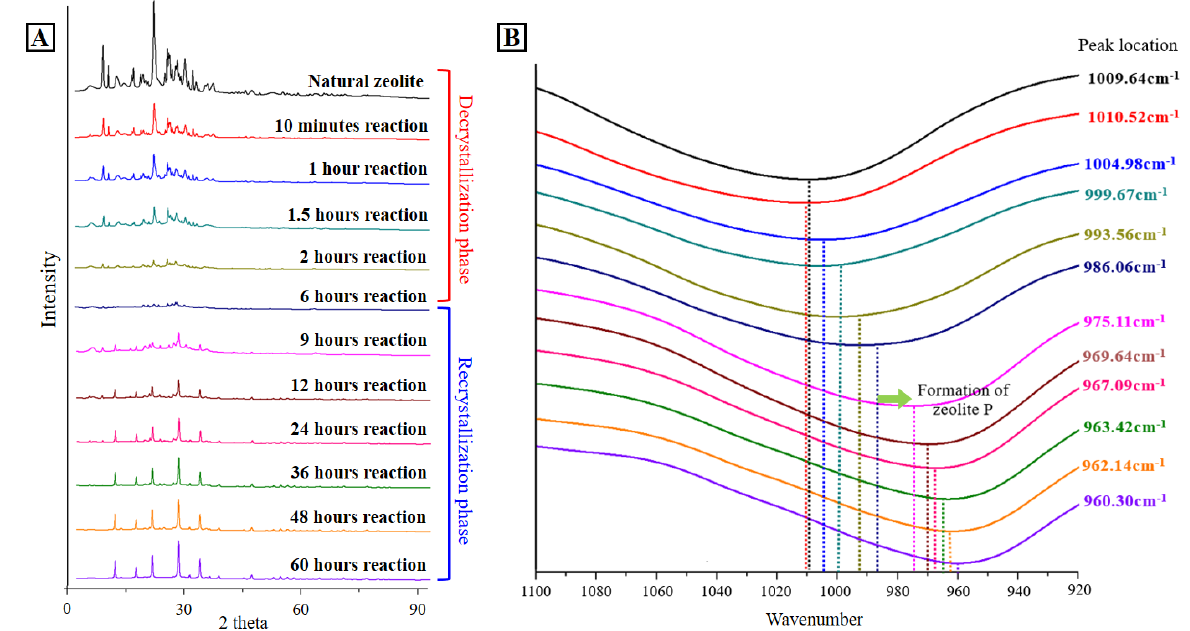
Figure 3. Zeolite phase transition analysis from natural zeolite to NaP zeolite by XRD pattern ( A ) and FT-IR peak ( B ) at different reaction.